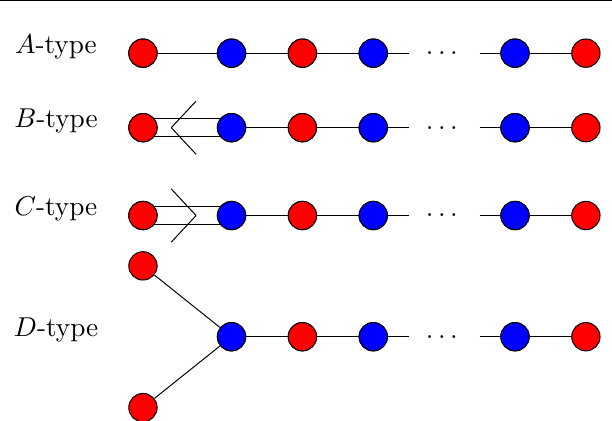
Table 1. The Dynkin types of orthosymplectic quivers relevant for this paper. Red nodes represent special orthogonal groups and blue represent symplectic groups, see